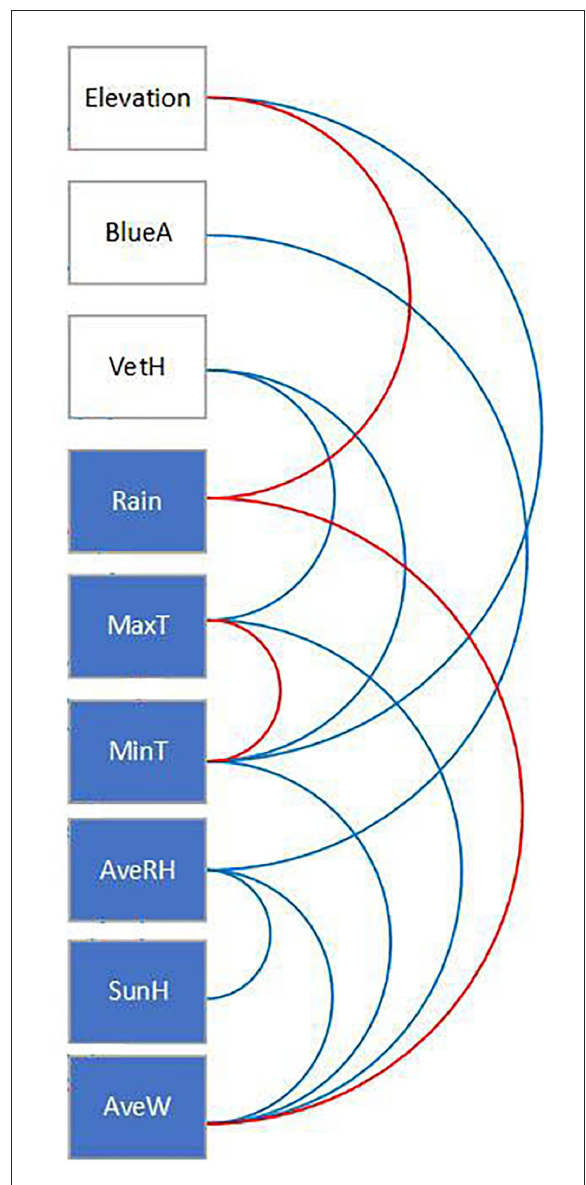
FIGURE6 Arc-diagram of correlations between parameters about landscape metrics and microclimatic factors. Lines in red link two parameters that had a positive relationship and those in blue link two parameters with a negative relationship. BlueA, blue-space area; VegH, vegetative height; Rain, rainfall; MaxT, maximum daily temperature; MinT, minimum daily temperature; AveRH, average RH; SunH, sunshine duration; AveW, average wind velocity every